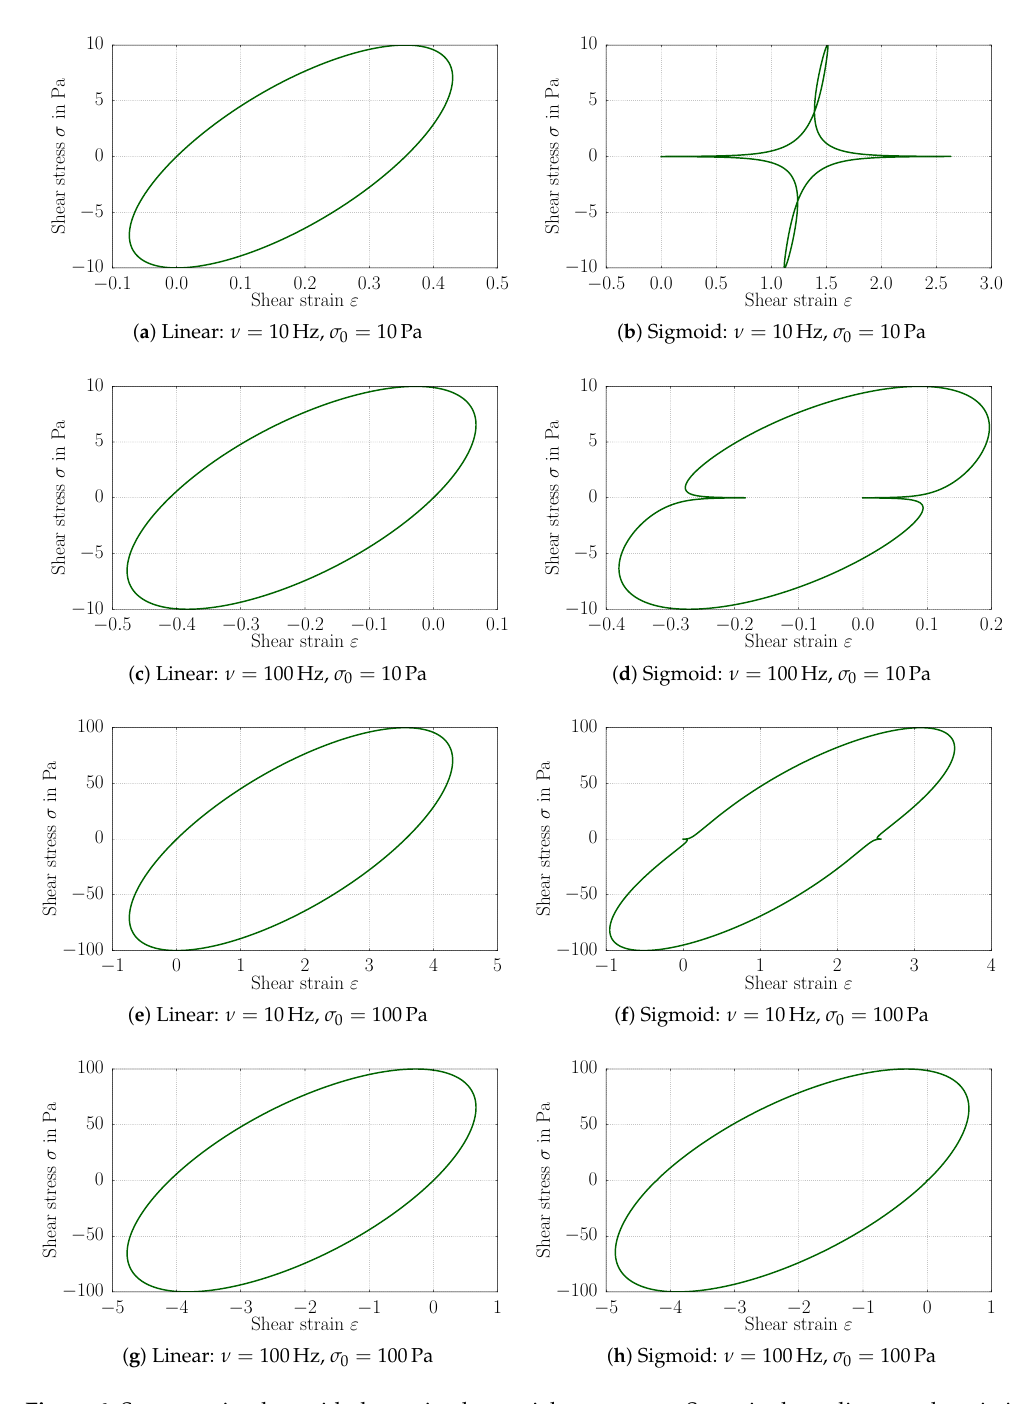
Figure 6. Stress-strain plots with determined material parameters. Stress in the ordinate and strain in the abscissa in L ISSAJOUS –B OWDITCH plots for the linear (left) and sigmoid (right) models for different amplitudes and